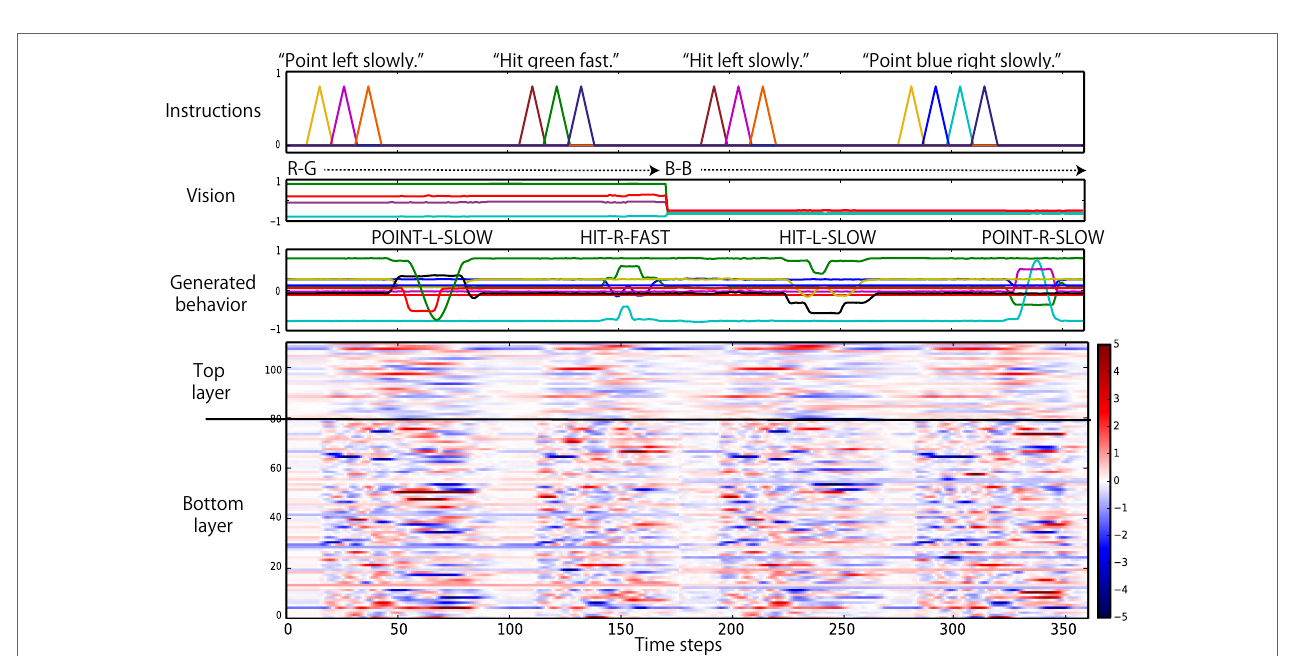
FIGURE 6 | (A) The worst unexperienced episode that scored the largest RMSE (0.0203) in the evaluation of Model 2. The solid lines are generated joint angles, and the broken lines indicate correct angles. (B) The worst unexperienced episode that scored the largest RMSE (0.0543) in the evaluation of Model 3. Only the five joints on the left arm are plotted, because the robot generated POINT-LEFT-FAST behavior in these episodes.